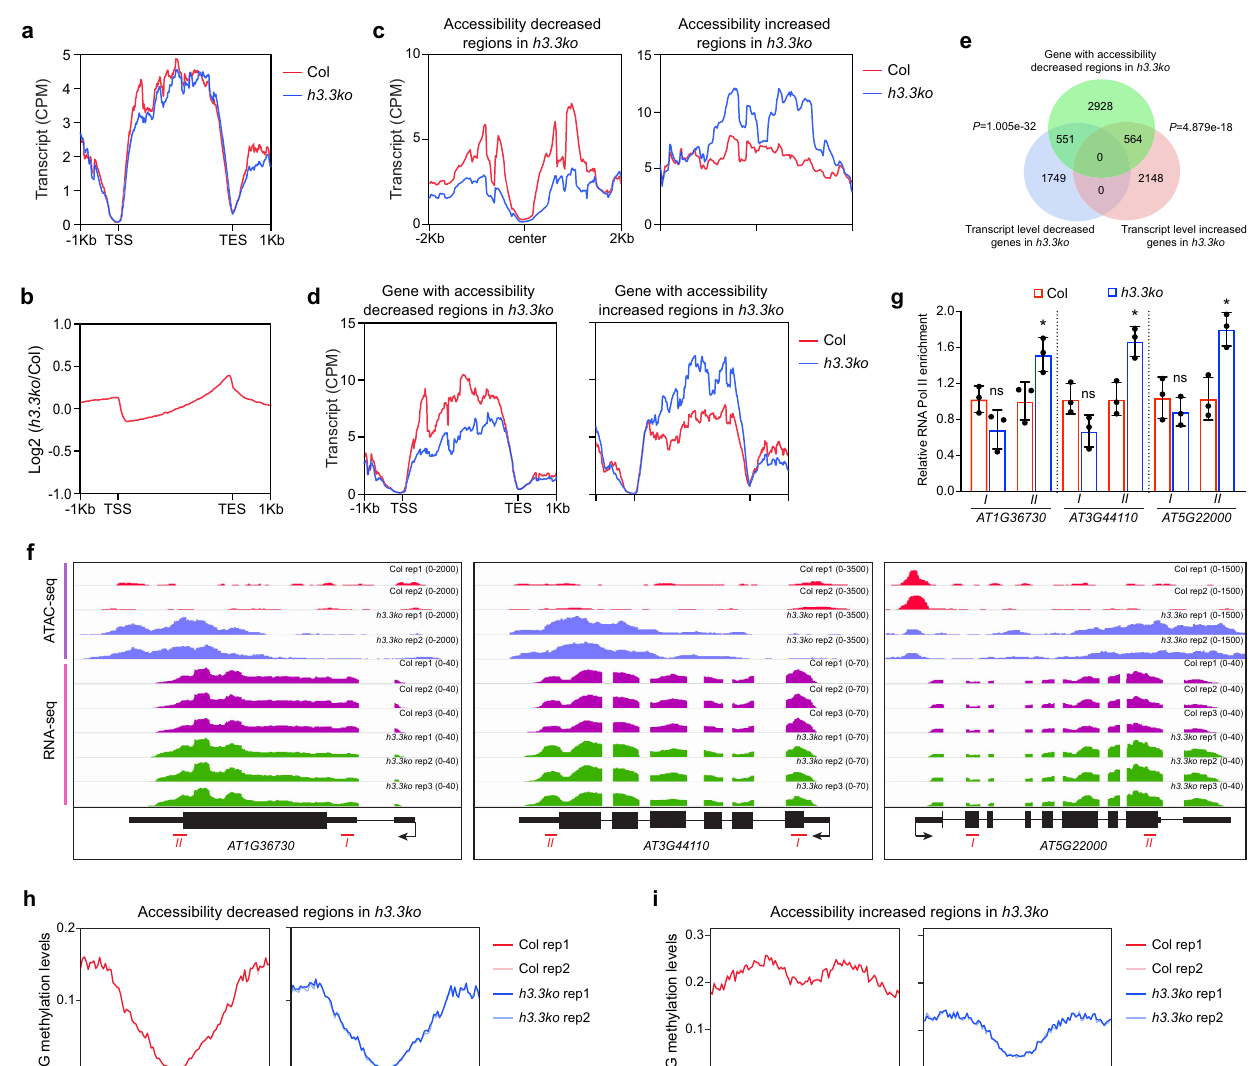
Fig. 5 | Altered chromatin accessibility in h3.3ko correlates with changes in transcription and gene body DNA methylation. a Metaplot of transcripts in Col and h3.3ko matureseeds over allgenes.The pro fi les weregenerated after merging three biological replicates. b Metaplot of h3.3ko transcripts vs Col transcripts in mature seeds over all genes. The pro fi les were generated after merging three bio- logical replicates. c Metaplot of transcripts in Col and h3.3ko mature seeds over accessibility signi fi cantly decreased and increased regions in mature h3.3ko seeds compared with Col. The pro fi les were generated after merging three biological replicates. d MetaplotoftranscriptsinColand h3.3ko matureseedsovergeneswith accessibility signi fi cantly decreased and increased regions in mature h3.3ko seeds compared with Col. The pro fi les were generated after merging three biological replicates. e Venn diagrams of accessibility signi fi cantly decreased region- associatedgenesinmature h3.3ko seedsandtranscriptlevelsigni fi cantlydecreased